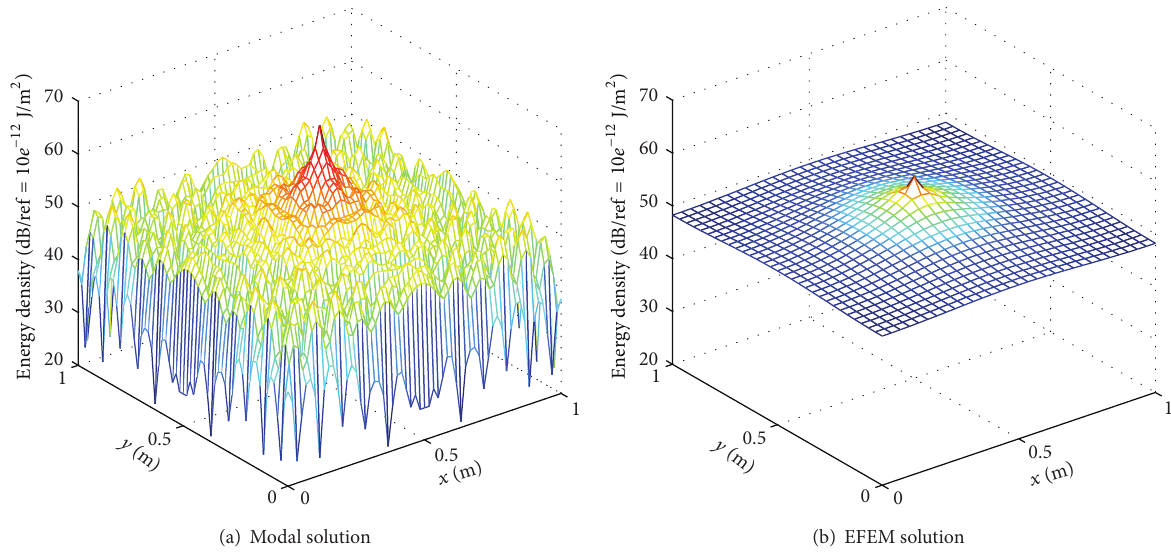
Figure 7: The energy density distributions of the plate in case 4 calculated by both modal superposition method and EFEM.